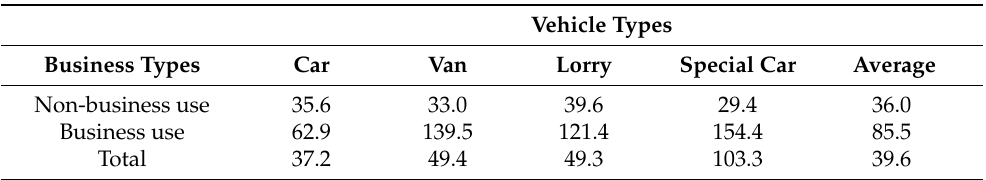
Table 4. Average daily driving distance (km) for general vehicles in South Korea (KOSIS, South Korea, 4 August 2022).